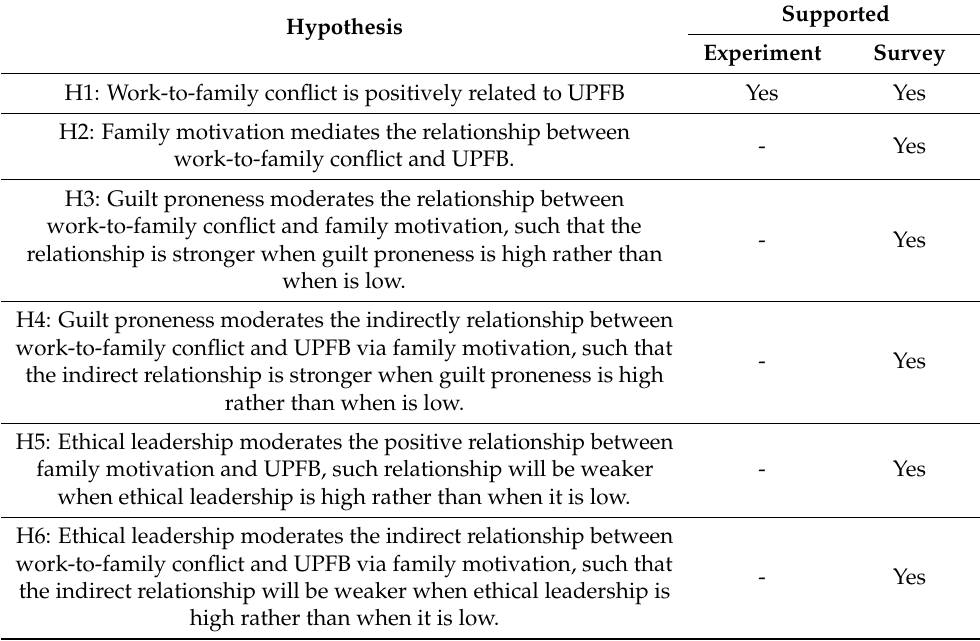
Table 5. Summery of Hypotheses Testing.